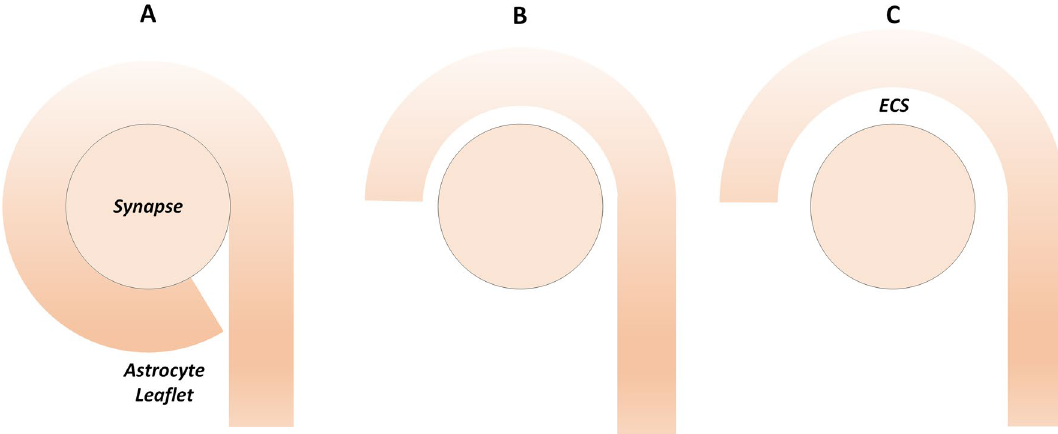
Figure 2. Schematic showing varying degrees of synaptic coverage by PsC. Three levels of PsC coverage represent the PsC in intimate contact with the synapse ( A ), when the PsC semi-wraps the synapse ( B ) and when the PsC is loosely coupled to the synapse ( C ). To simulate the various astrocyte-synapse couplings, the ECS volume and extracellular diffusion surface area is increased as the PsC moves away from the